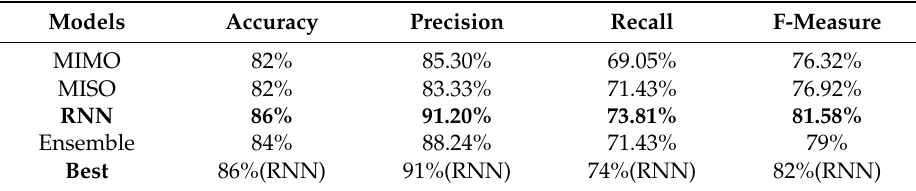
Table 6. Performance measures by all the models where T f is kept at